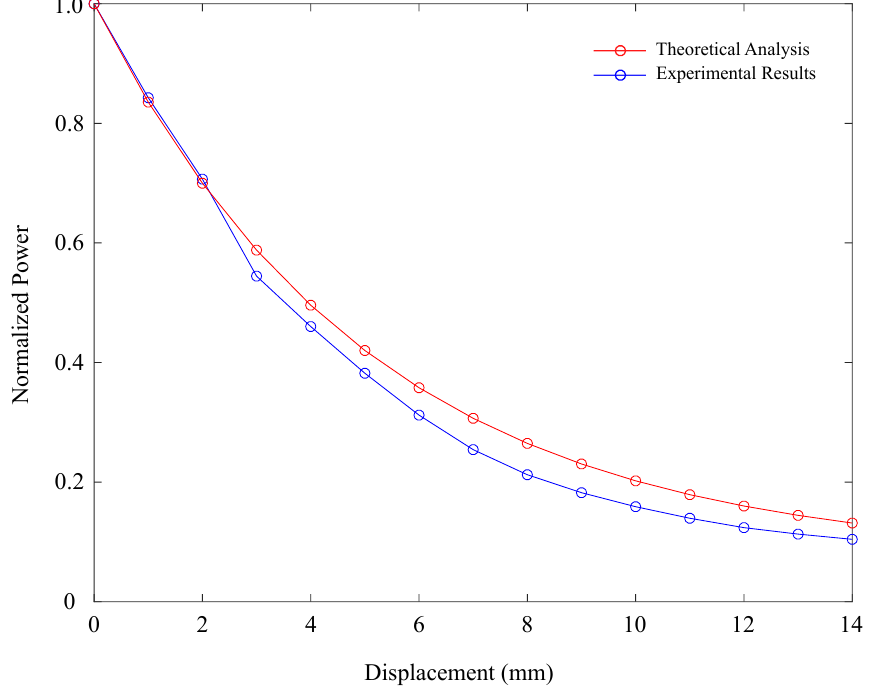
Figure 12. Analytical model adjusted (red line) to the sensor response attached to the elastic tendon (blue line), considering relative displacement between receiver and transmitter